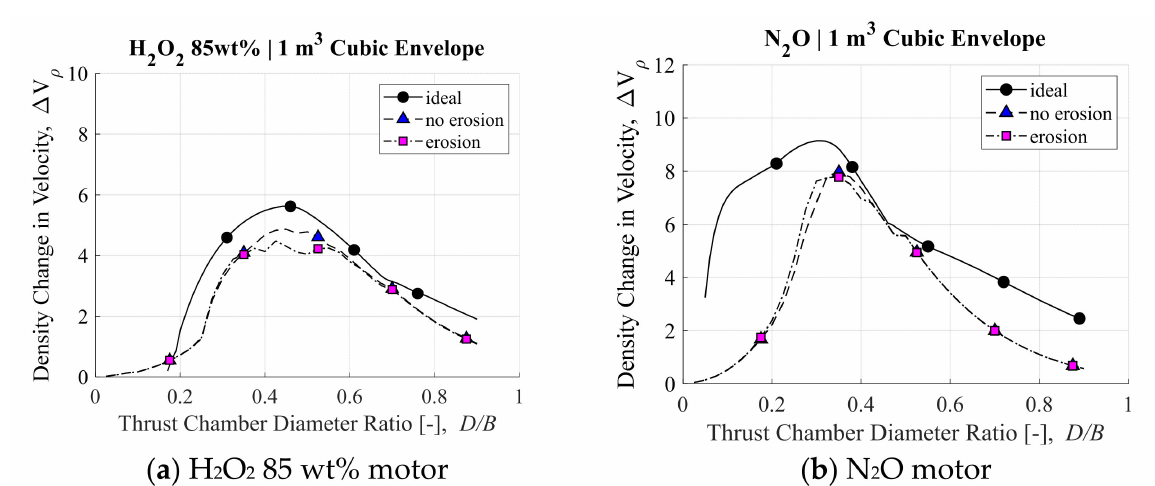
Figure 16. Comparison of ∆ V solutions spaces for cubic envelope.